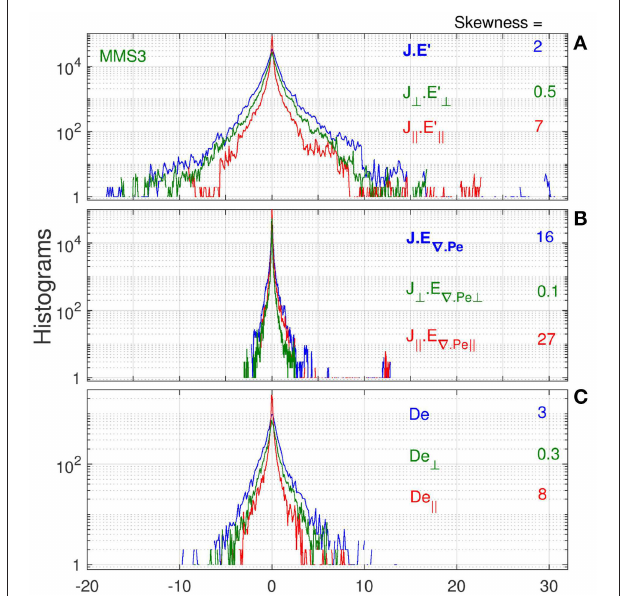
FIGURE 3 | (A–C) Histograms of EED measures and their perpendicular and parallel products from MMS3 sapcecraft; The color coded skewness associated with a histogram is shown for each component on the right.